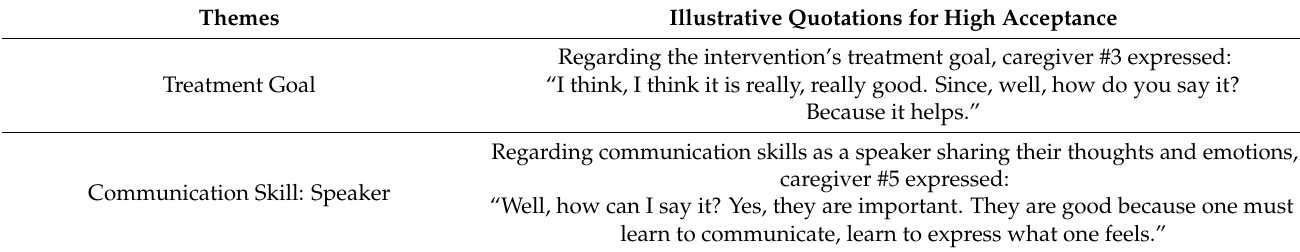
Table 4. Caregivers–Patients Support to Latinx coping advanced-cancer (CASA) illustrative quota- tions for the high acceptance